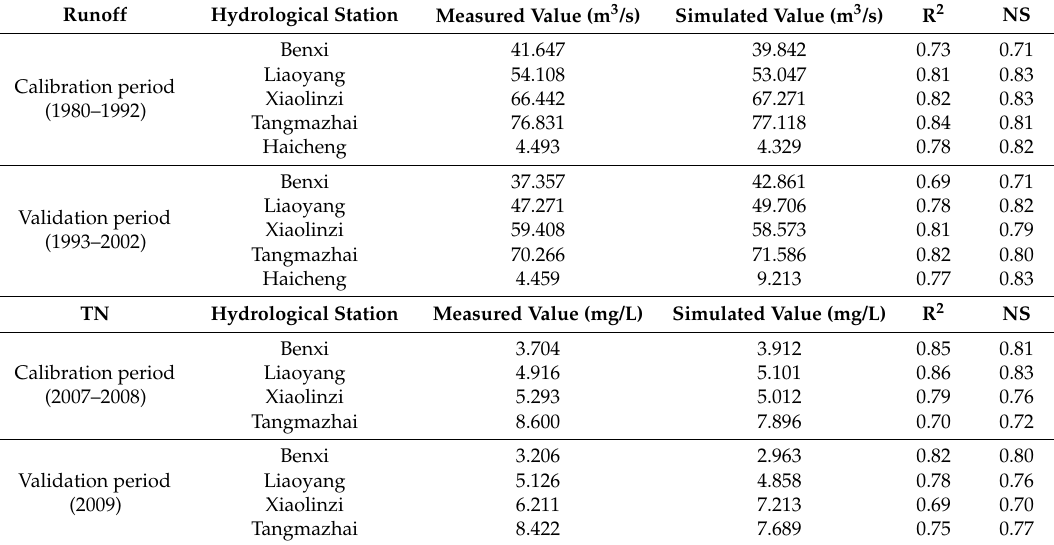
Table 5. Model performance statistics of the simulated and measured runoff and total nitrogen (TN) during calibration and validation.